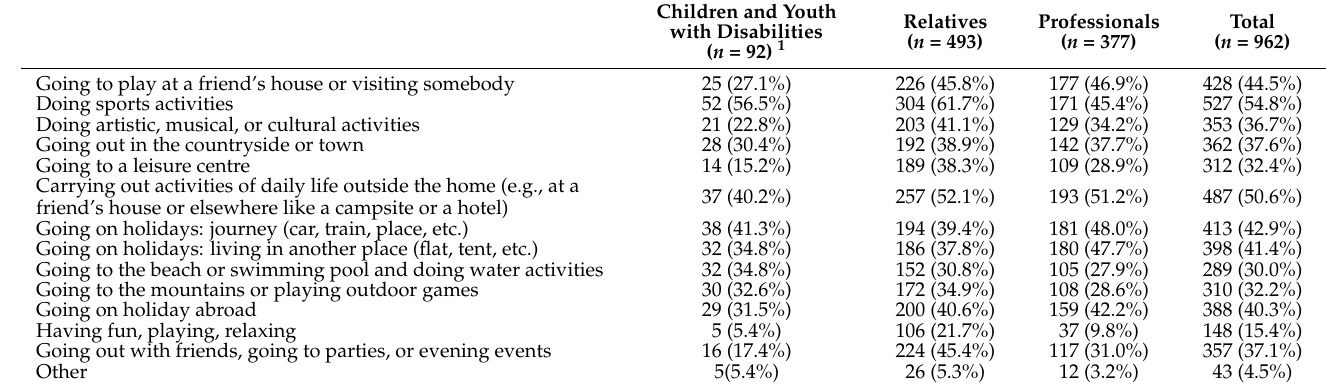
Table 3. Study results for difficulties during a day off (weekends,